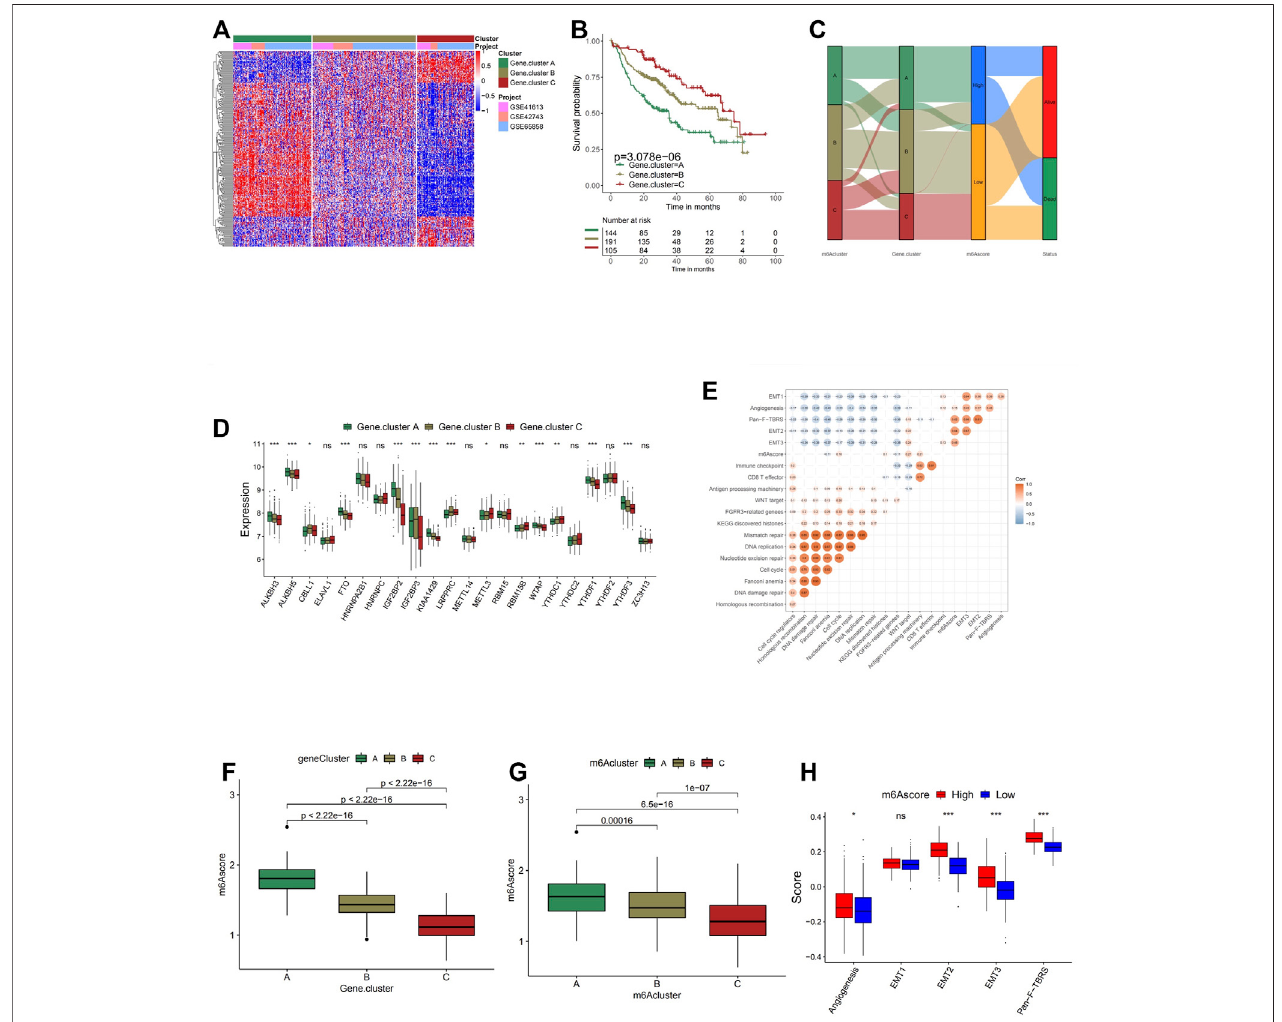
FIGURE 4 | Construction of m6A signatures. (A) Unsupervised clustering of overlapping m6A phenotype-related genes to classify patients into different genomic subtypes, termed as m6A gene clusters A – C. The gene clusters and molecular subtypes were used as patient annotations. (B) Kaplan – Meier curves indicate that m6A modi fi cation genomic phenotypes were markedly related to the overall survival of 440 patients, of which 144 cases were in gene cluster A, 191 cases in gene cluster B, and105casesingeneclusterC( p < 0.0001,log-ranktest). (C) Theexpressionof21m6Aregulatorsinthreegeneclusters.Theupperandlowerendsoftheboxes representtheinterquartilerangeofvalues.Thelinesintheboxesrepresentthemedianvalue,andblackdotsshowoutliers.Theasterisksrepresentthestatistical p -value (* p < 0.05; ** p < 0.01; *** p < 0.001). The one-way ANOVA test was used to test the statistical differences among three gene clusters. (D) Alluvial diagram showing the changes of m6A clusters, gene cluster, m6Ascore, and outcomes. (E) Correlations between m6Ascore and the known gene signatures using Spearman ’ s analysis. Negative correlation ismarked in blue and positive correlation with orange. (F) Differences in m6Ascore among three gene clusters. The Kruskal – Wallis test wasused to compare the statistical difference between three gene clusters ( p < 0.001). (G) Differences in m6Ascore among three m6A modi fi cation patterns ( p < 0.001, Kruskal – Wallistest). (H) Differencesinstroma-activatedpathwaysbetweenhighm6Ascoreandlowm6Ascoregroups.Theupperandlowerendsoftheboxesrepresent the interquartile range of values. The lines in the boxes represent the median value. The asterisks represent the statistical p -value (* p < 0.05; ** p < 0.01; *** p < 0.001).